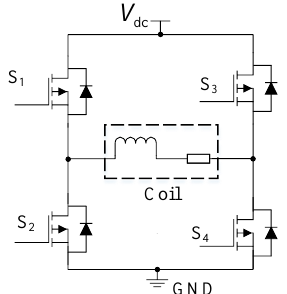
Figure 3. Full-bridge topology of an SPA .